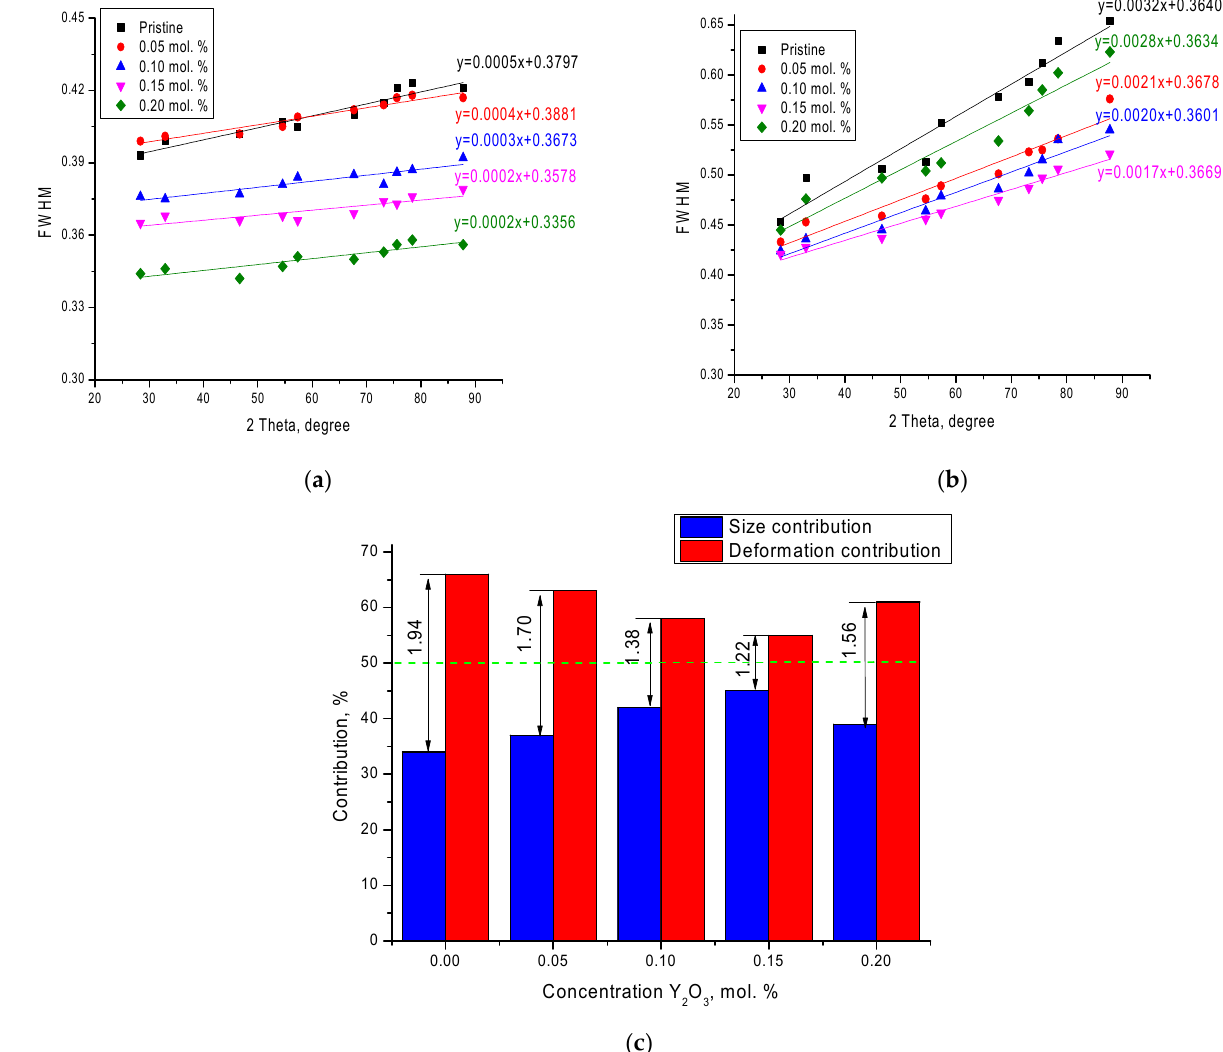
Figure 7. Data of angular dependence of the change in the FWHM values of the samples under study: ( a ) depending on the concentration of the dopant; ( b ) after irradiation. ( c ) Diagram of the estimation of the dimensional and deformation contributions to the change in the diffraction maxima of irradiated samples.